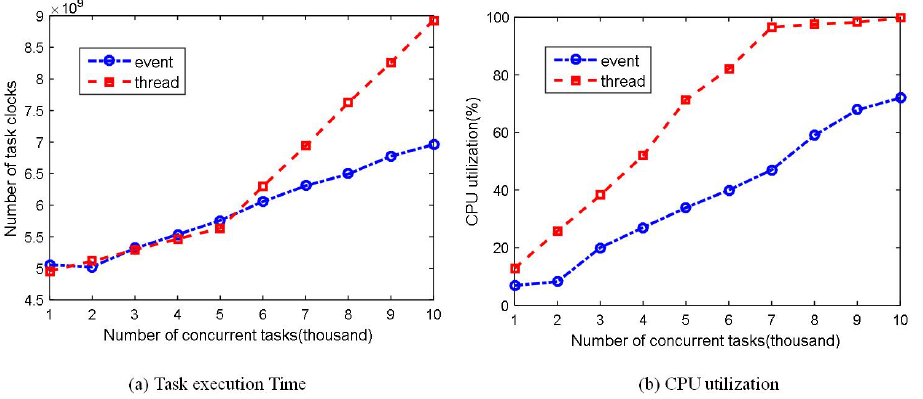
Figure 5. Compare the event-driven and multi-threaded